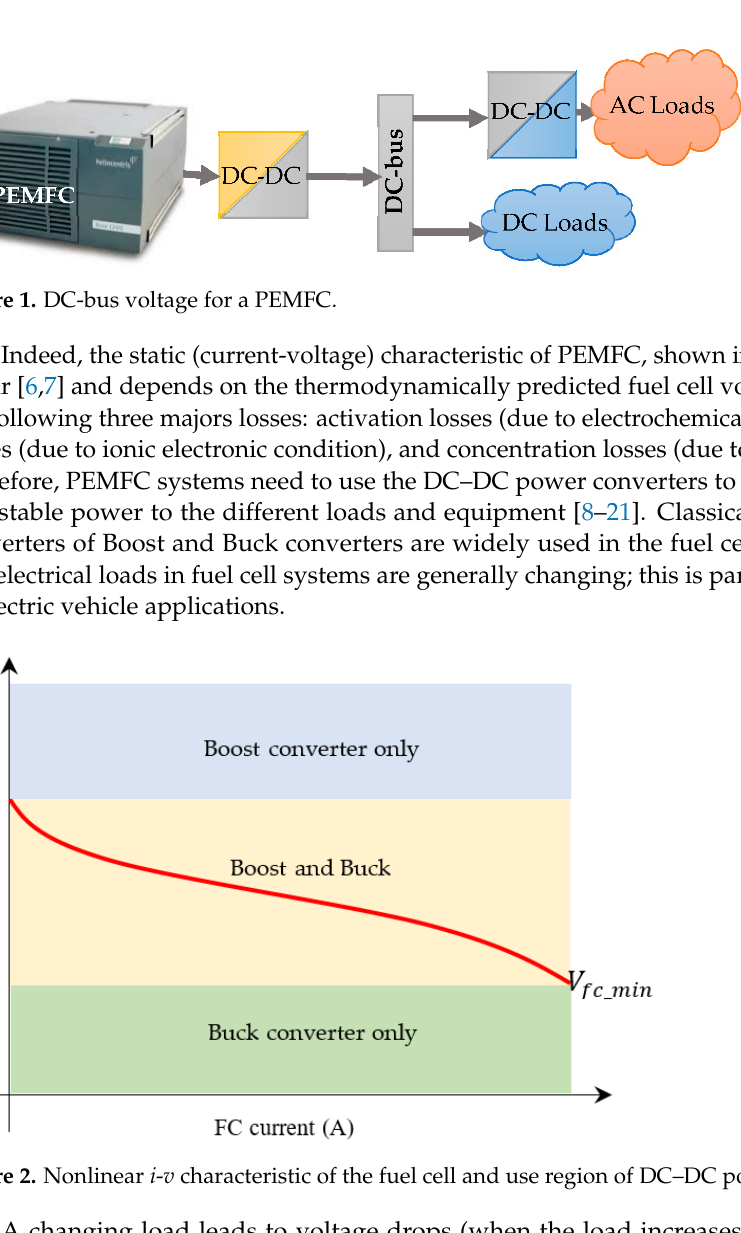
Figure 1. DC-bus voltage for a PEMFC.